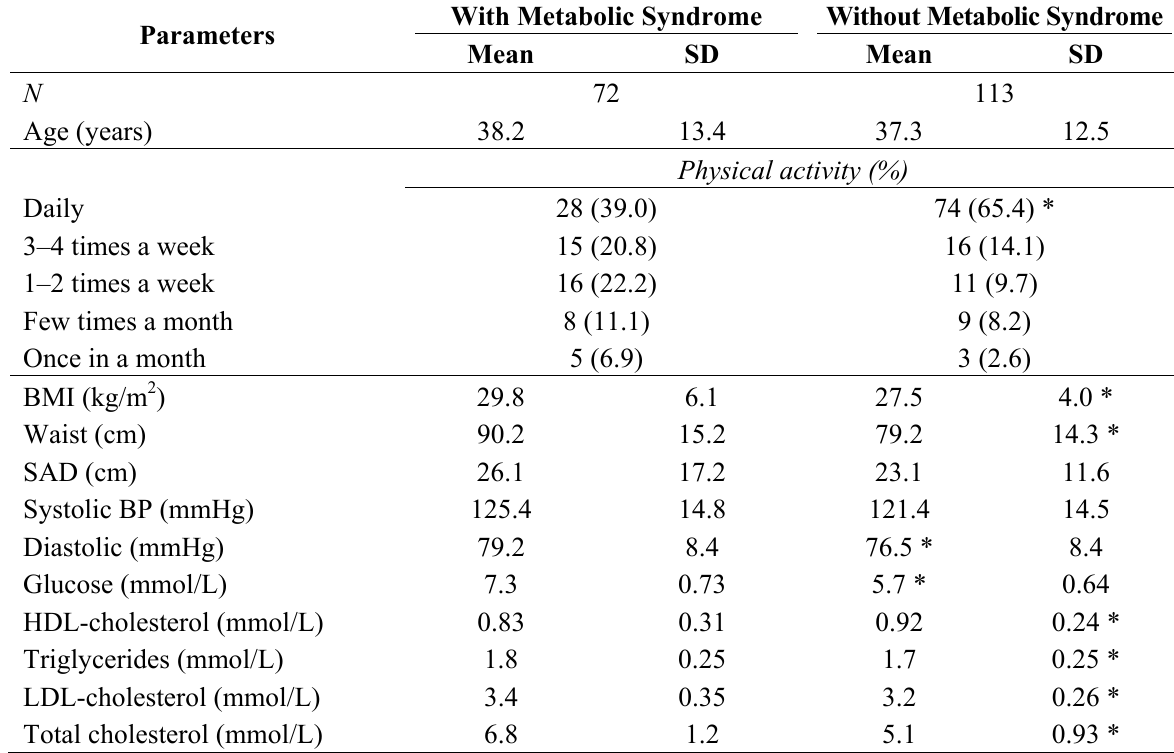
Table 1. General characteristics of study participants [Mean ± standard deviation (SD)]. BMI, body mass index; BP, blood pressure; SAD, sagittal abdominal diameter ;